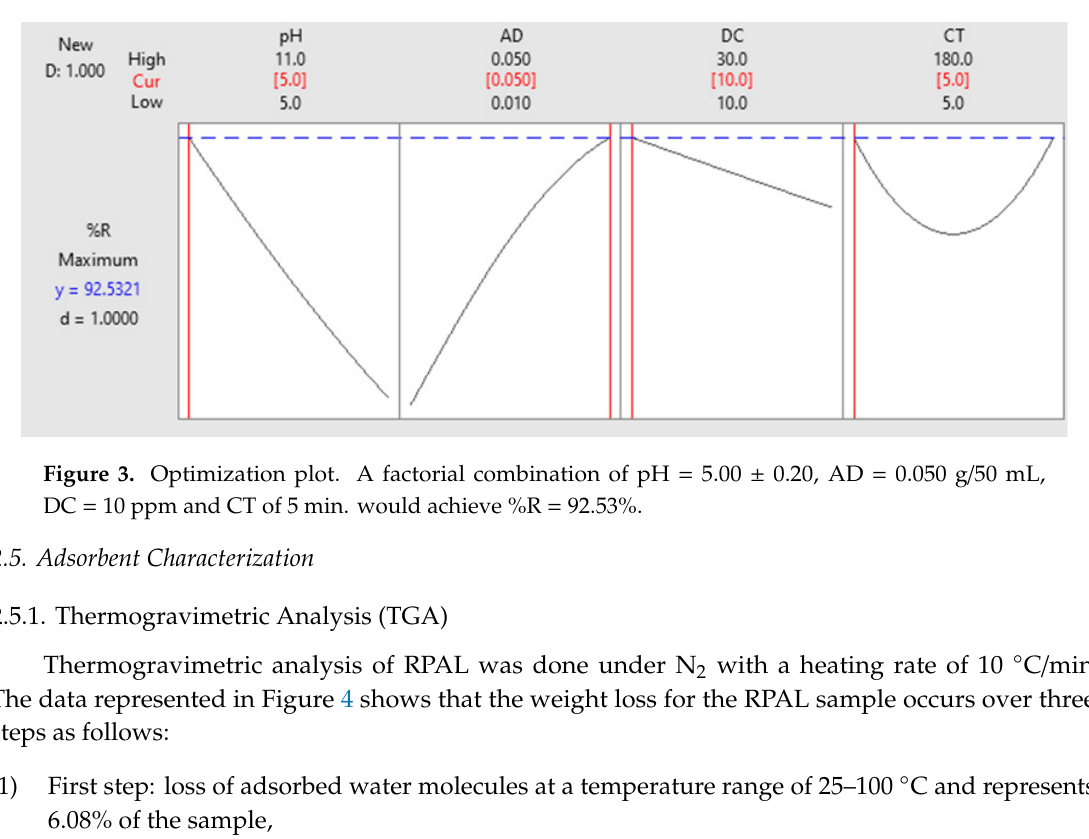
Figure 2. Response contour plots for the %R. Dark grey regions represent regions where maximum %R could be obtained using the factorial combination in each panel.